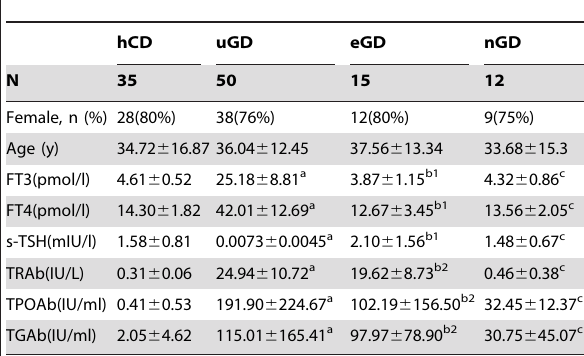
Table 1. Clinical characteristics of the